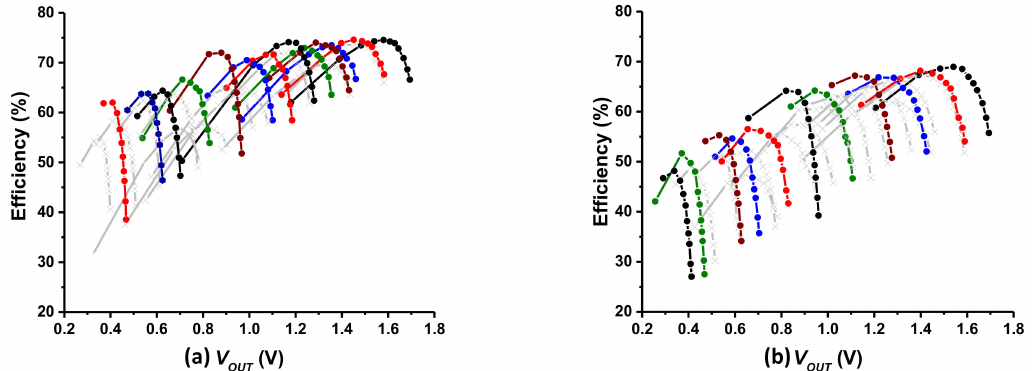
Figure 19. Efficiency vs. V OUT at I LOAD = 5 µ A ( a ) Leaf 1 and 2 enabled. ( b ) All leaves enabled (Max. switch size).